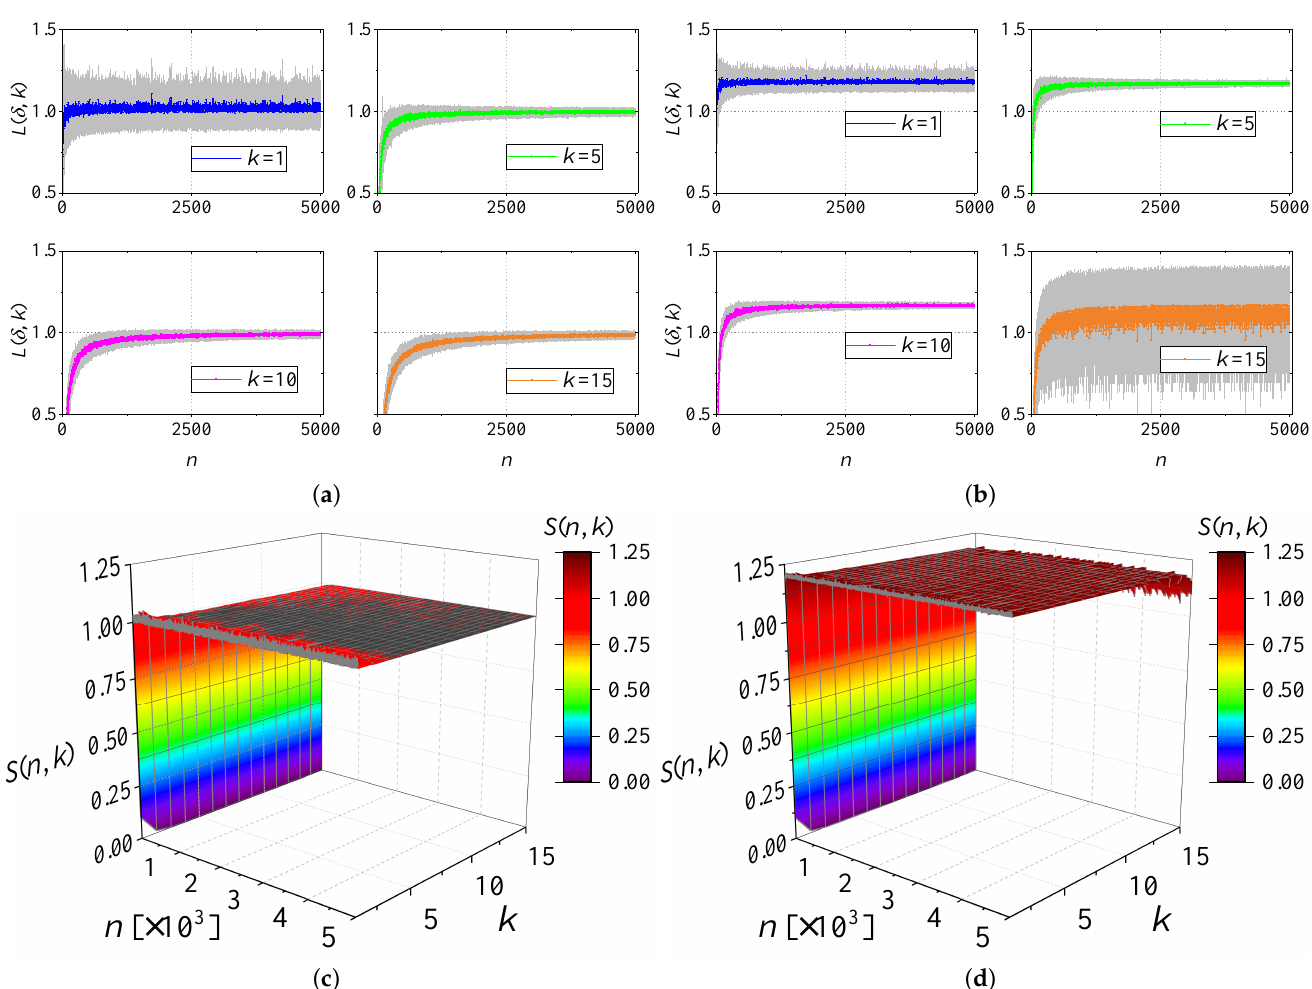
Figure 9. ( a ) Sensitivity level for the STM, considering 100 randomly selected initial conditions; ( b ) Sensitivity level for the FC, considering 100 randomly selected initial conditions; ( c ) Sensitivity index for the STM and ( d ) Sensitivity index for the FC. In all cases we consider k ∈ [1, 15], x 0 = 0.1, µ = 1.0, α = 2.0, and n ∈ [1,